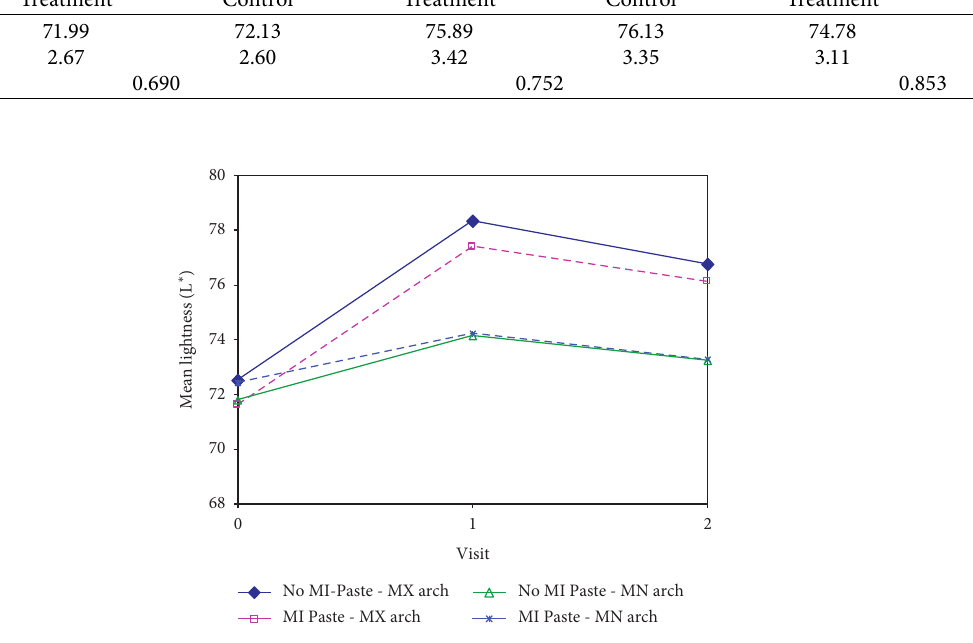
Figure 3: Average lightness value over